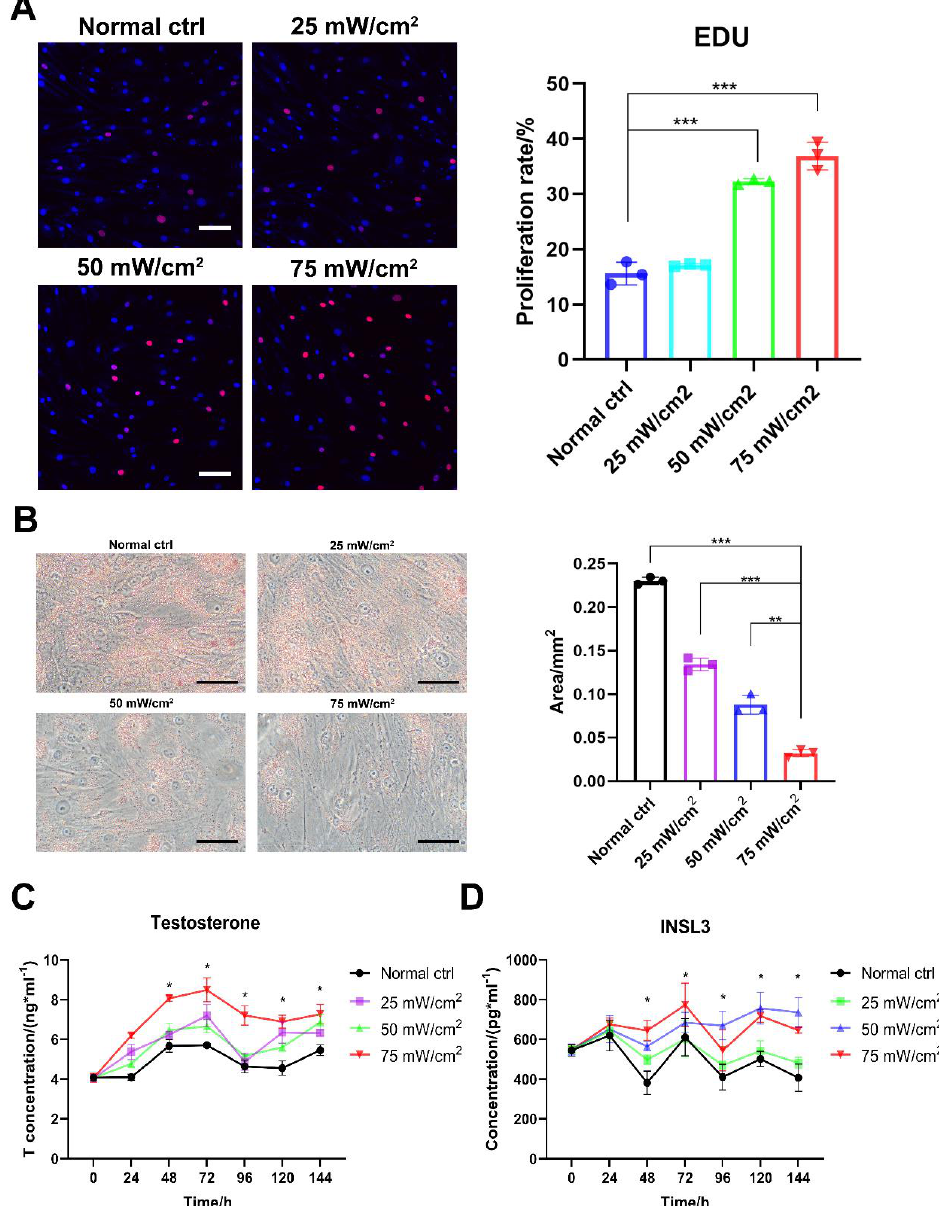
Figure 3. LIPUS improves proliferation and secretion function of aged LCs. LIPUS stimulation at 50 and 75 mW/cm 2 promoted a significant increase in LCs proliferation compared with 25 mW/cm 2 ( A ). Oil Red O staining showed a significant decrease in the amount of lipid droplets in LCs after LIPUS treatment of cells and an increase with higher energy ( B ). Testosterone and INSL3 levels were significantly higher in group treated with 50 mW/cm 2 and 75 mW/cm 2 after three consecutive days of LIPUS stimulation and following three days compared to the untreated group ( C , D ). The scale bar represents 100 μm. *** p < 0.001, ** p < 0.01, * p < 0.05.